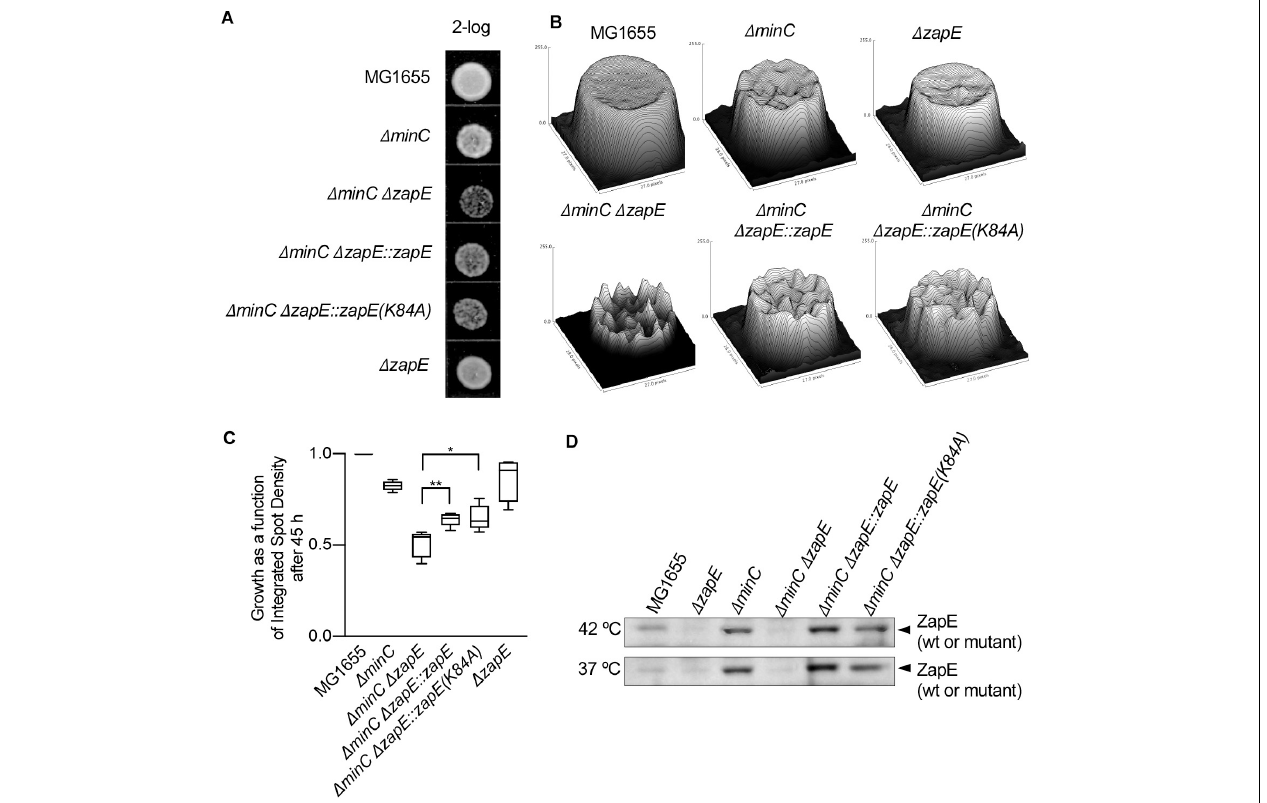
FIGURE 5 | Cells deleted for zapE and minC grow slowly after exposure to thermal and oxygen stress. (A) Overnight cultures MG1655, MG1655 (cid:49) zapE, MG1655 (cid:49) minC, MG1655 (cid:49) minC (cid:49) zapE : kan, MG1655 (cid:49) minC (cid:49) zapE : zapE(K84A), and MG1655 (cid:49) minC (cid:49) zapE : zapE were diluted in to fresh medium (LB broth) and exposed to thermal stress (42 ◦ C) and low oxygen conditions for 3 h. Then, dilutions (2-log) were spotted (5 µ l) on no salt LB agar and incubated at room temperature. (B) Images of spots were collected and analyzed by surface mapping in ImageJ to compare biomass and visualized in a three-dimensional plot of density versus pixel area. Biomass was evaluated by comparing integrated spot density after 45 h of growth. (C) Growth analysis in (B) was collected across five replicate experiments. Average biomass as a function of integrated spot density is represented as a box and whiskers plot. (p-values are as follows: * < 0.05 and ** < 0.01). (D) Overnight cultures MG1655, MG1655 (cid:49) zapE, MG1655 (cid:49) minC, MG1655 (cid:49) minC (cid:49) zapE : kan, MG1655 (cid:49) minC (cid:49) zapE : zapE(K84A), and MG1655 (cid:49) minC (cid:49) zapE : zapE were diluted into fresh medium (LB broth) and exposed to thermal stress (42 ◦ C) and low oxygen conditions, or at 37 ◦ C and shaking, for 3 h. Cells were harvested and analyzed for ZapE expression by